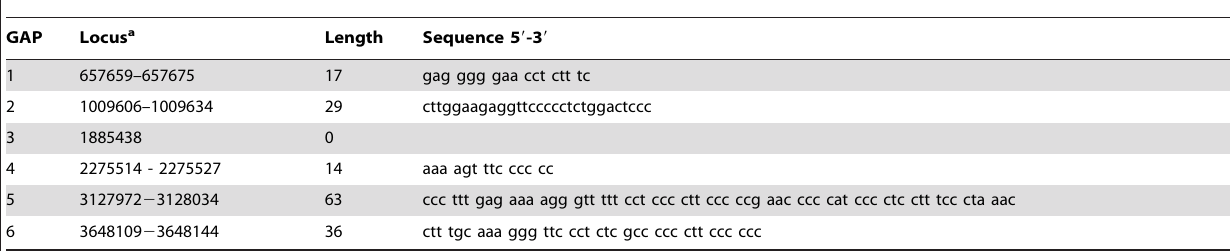
Table 3. Sequences of the Six D. desulfuricans ND132 Gaps.